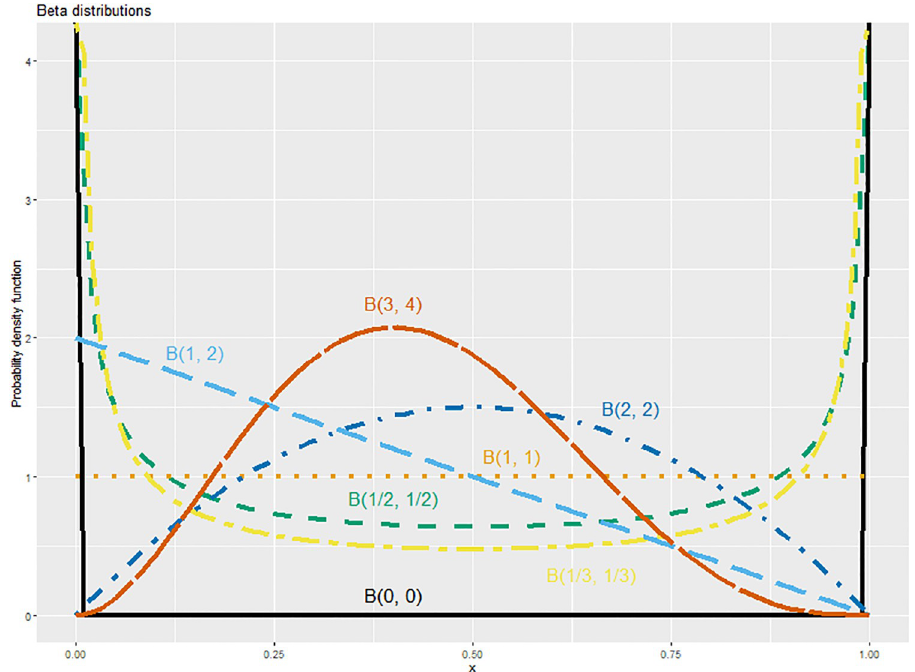
Fig 1. Plot of beta distributions used as priors. Probability density functions for beta distributions with various shape parameters.